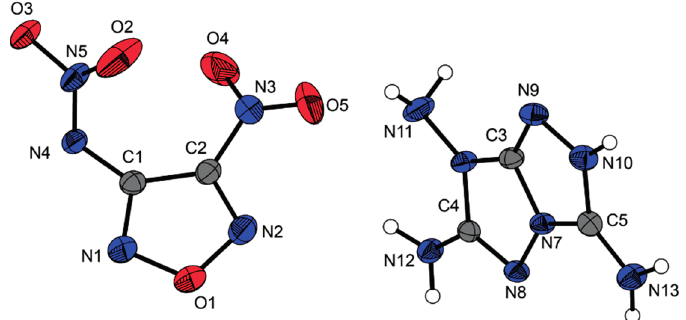
Figure 6. Molecular unit of 8 . Ellipsoids are drawn at the 50% probability level.